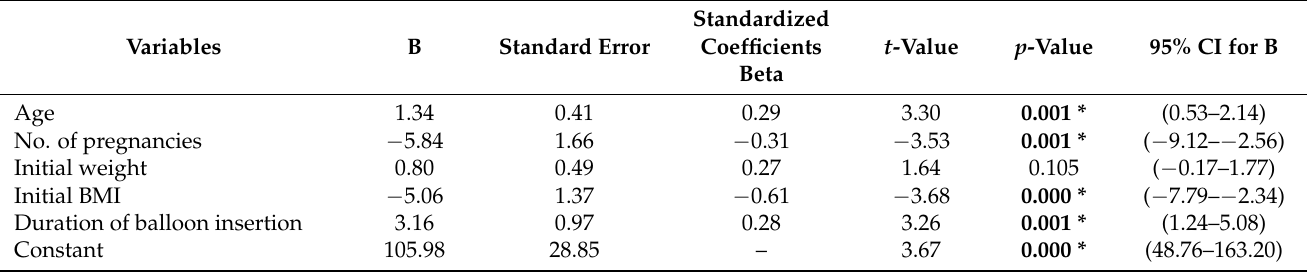
Table 5. Linear regression model for excess weight loss.